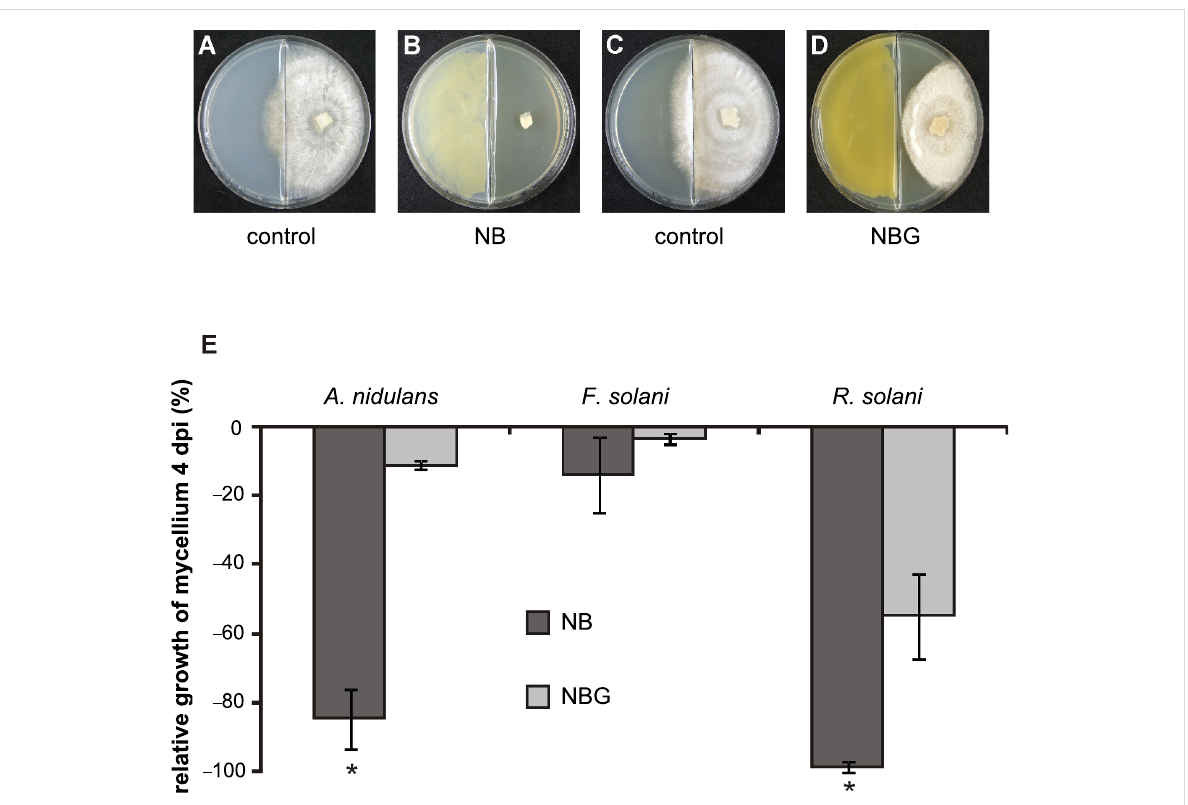
Figure 1: Cocultivation of Xanthomonas campestris pv. vesicatoria 85-10 with three fungi on different media. (A) Control experiment: Cultivation of Rhizoctonia solani on NB (day 4). (B) Cocultivation of X. c. pv. vesicatoria 85-10 on NB with Rhizoctonia solani (day 4). (C) Control experiment: Culti- vation of Rhizoctonia solani on NBG (day 4). (D) Cocultivation of X. c. pv. vesicatoria 85-10 on NBG with Rhizoctonia solani (day 4). (E) Quantifica- tion of the inhibition of fungal mycelium growth during cocultivation with X. c. pv. vesicatoria 85-10, either grown on NB (black column) or NBG (grey column). Fungi: Aspergillus nidulans, Fusarium solani and Rhizoctonia solani . (4 dpi: four days after inoculation; NBG: nutrient broth (NB) II agar plus 1.1% glucose; *: growth significantly different compared to the control, p < 0.01 according to